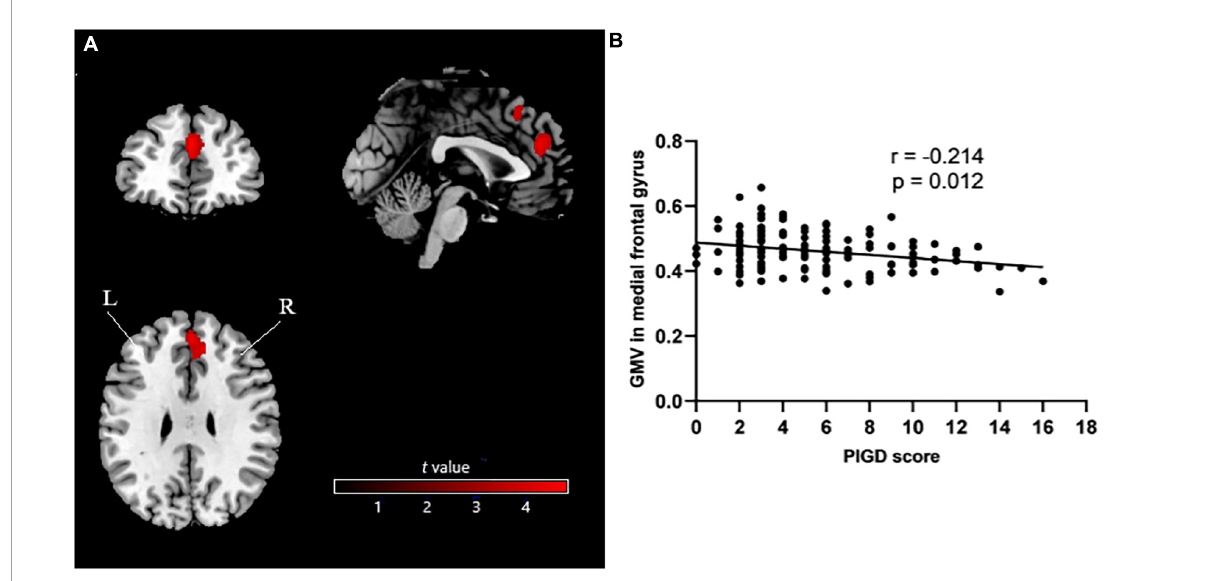
FIGURE1 (A) Voxel-based morphometry showing smaller GMV in medial frontal gyrus (mainly on the right side) in PIGD patients than in TD patients. (B) Analysis of potential correlation between GMV in medial frontal gyrus and PIGD score. GMV, gray matter volume; PIGD, postural instability/gait difficulty; TD, tremor-dominant; L, left; R, right.